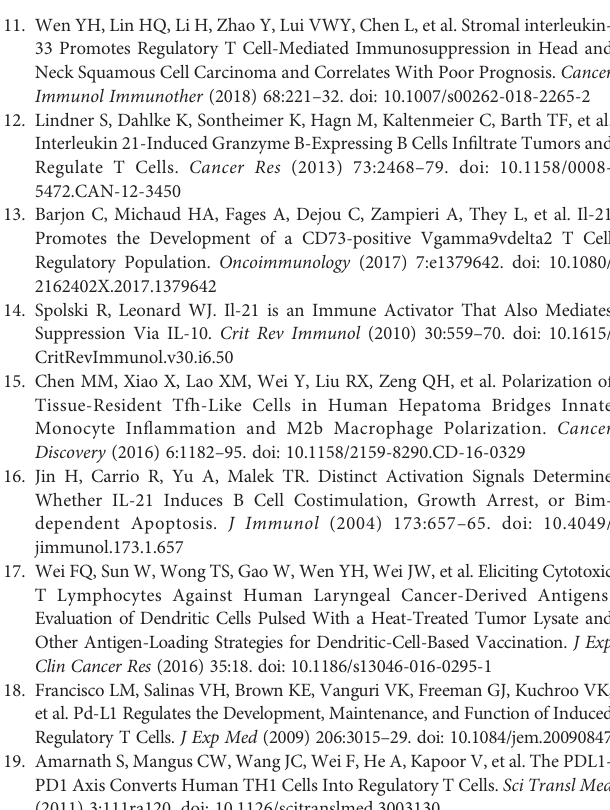
Supplementary Figure 1 | Gating strategy of fl ow cytometric plot for tumor in fi ltrating lymphocytes. Supplementary Figure 2 | (A) Representative fl ow cytometric histograms of the expression of IL-21R on Treg cells and conventional T cells (CD45+CD3+CD4+ CD8-CD25-FOXP3-) in tumor are shown; (B) The frequencies of IL-21R+ Treg cells were signi fi cantly higher compared with conventional T cells, n=5, *P < 0.05. Supplementary Figure 3 | Proliferation of CD8+ T responder cells were assessed after 72h by fl ow cytometry. (A, B) Induced Tregs were cocultured with CFSE labeled TAA- speci fi c CD8+ T responder cells at ratios of 1:4 and in the presence of anti-CD3/anti-CD28 antibodies. n=5, *P < 0.05. Supplementary Figure 4 | Induced Treg cocultured with TAA-speci fi c CD4+ T cells. Tregs induced by IL-21high/PD-L1high tumor explants were cocultured with CD4+ T responder cells at ratios of 1:4 and in the presence of anti-CD3/anti-CD28 antibodies. (A) Proliferation of CFSE labeled TAA CD4+ T responder cells were assessedafter72hby fl owcytometry. ProductionofIFN- g (B) ,IL-2 (C) incocultured CD4+ T responder cells was detected by intracellular staining. (D) Quanti fi cation of proliferation and percentage of IFN- g , IL-2 of CD4+ T responder cells. n=5, n.s., not signi fi cant. Supplementary Figure 5 | Induced Treg cocultured with TAA-speci fi c CD8+ T cells Tregs induced by IL-21high/PD-L1high tumor explants were cocultured with CD8+ T responder cells at ratios of 1:4 and in the presence of anti-CD3/anti-CD28 antibodies. (A) Proliferation of CFSE labeled TAA CD8+ T responder cells were assessed after72hby fl owcytometry. (B) TAA-speci fi c cytotoxicitywas determined by fl ow cytometry. Production of GranzymeB (C) , Perforin (D) in cocultured CD8+ T responder cells was detected by intracellular staining. (E) Quanti fi cation of proliferation, TAA-speci fi c cytotoxicity and percentage of GranzymeB, Perforin of CD8+ T responder cells. n=5, n.s., not signi fi